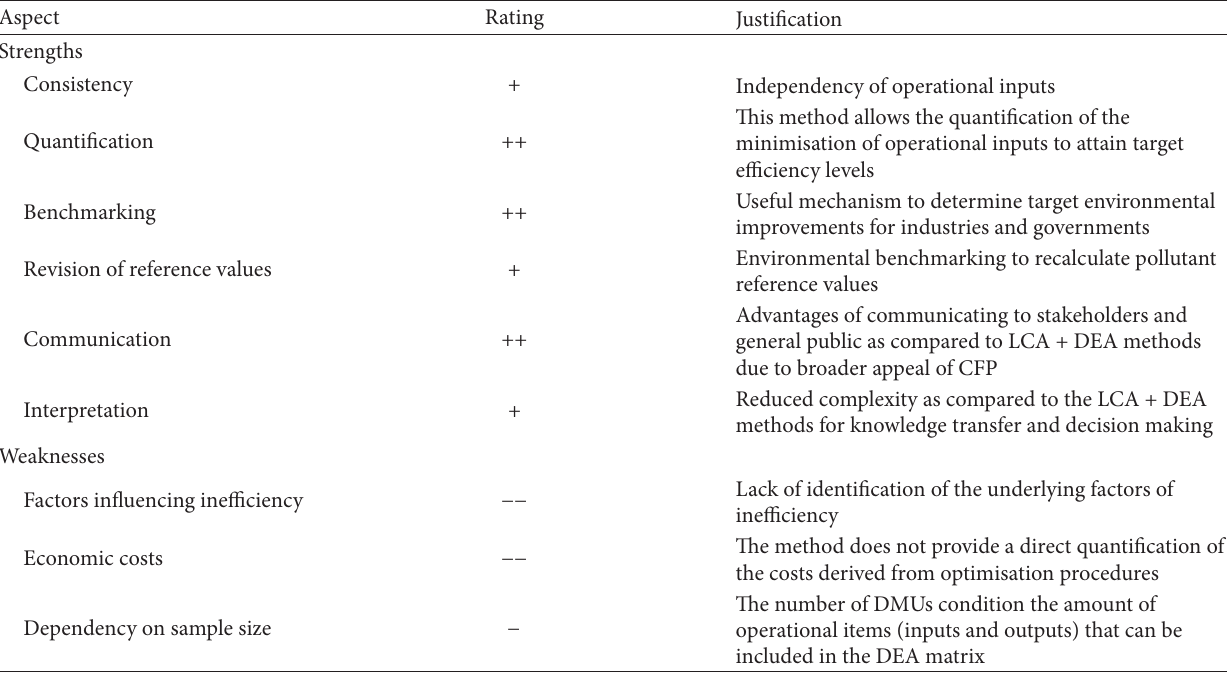
Table 2: Strengths and weaknesses of implementing the CFP + DEA